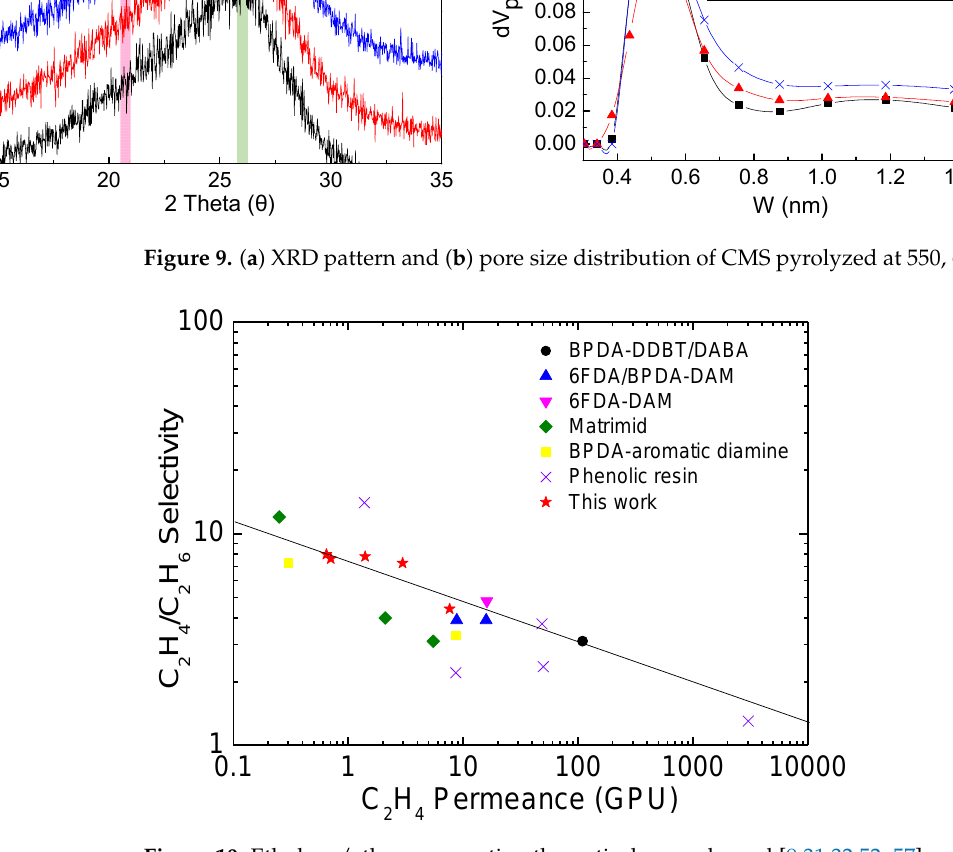
Figure 10. Ethylene/ethane separation theoretical upper bound [9,31,32,52 – 57] .